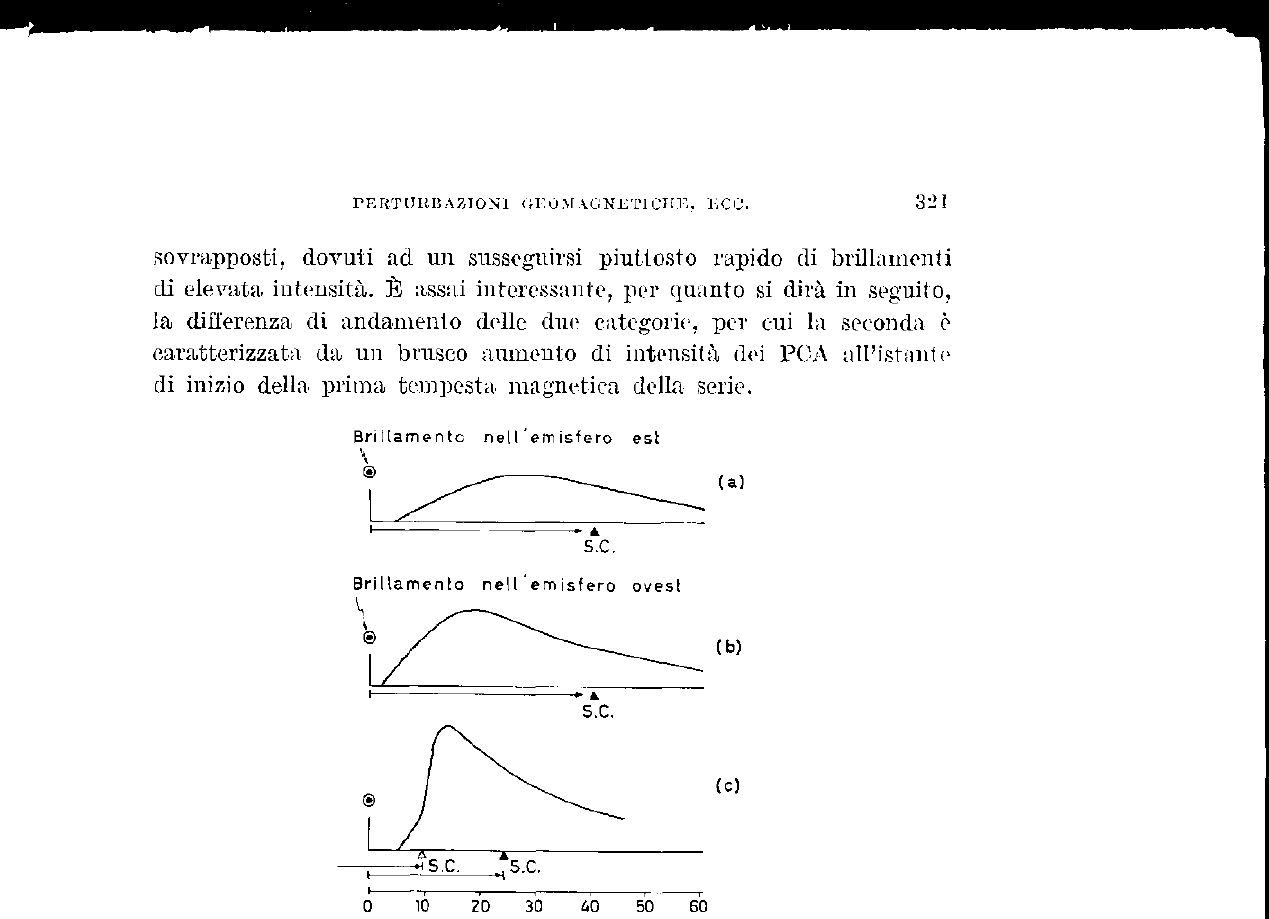
Fig. 5.45 - Variazione temporale media dei PCA singoli (figg. a, b) e complessi (fig. e) (secondo